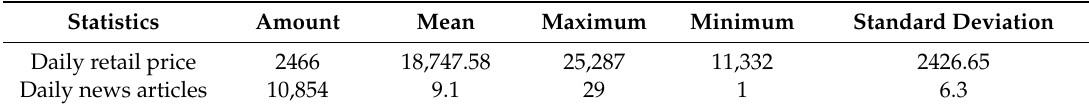
Table 4. Summary of datasets used in experiments (from January 2010 to December 2019).